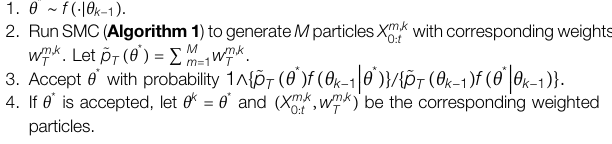
Algorithm 2 . Chopin et al. (2013, Section 1.2) point out